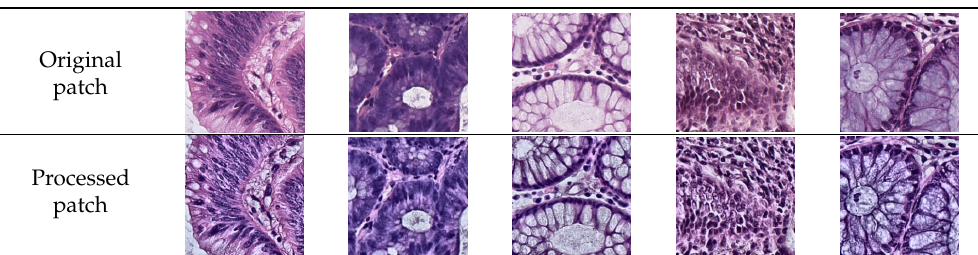
Table 1. Image preprocessing.